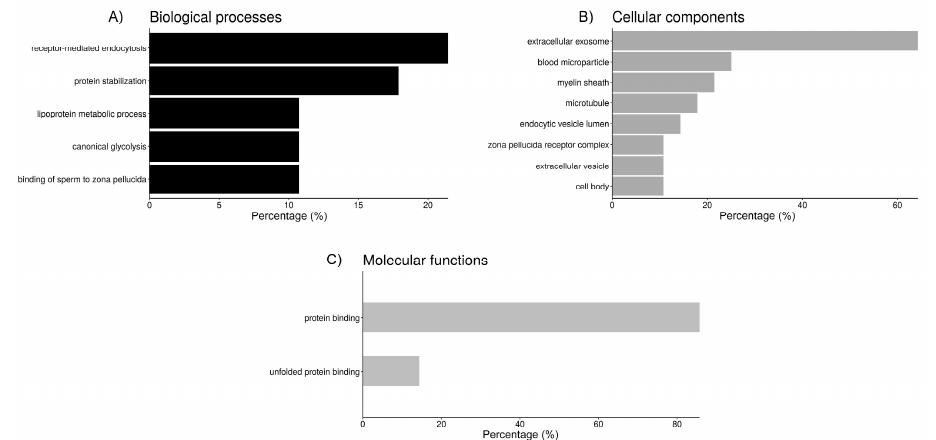
Figure 2. Bar chart representing the distribution of the proteins identified in spermatozoa incubated with uterine fluid (UF) according to the biological process ( A ), cellular component ( B ), and molecular function ( C ).